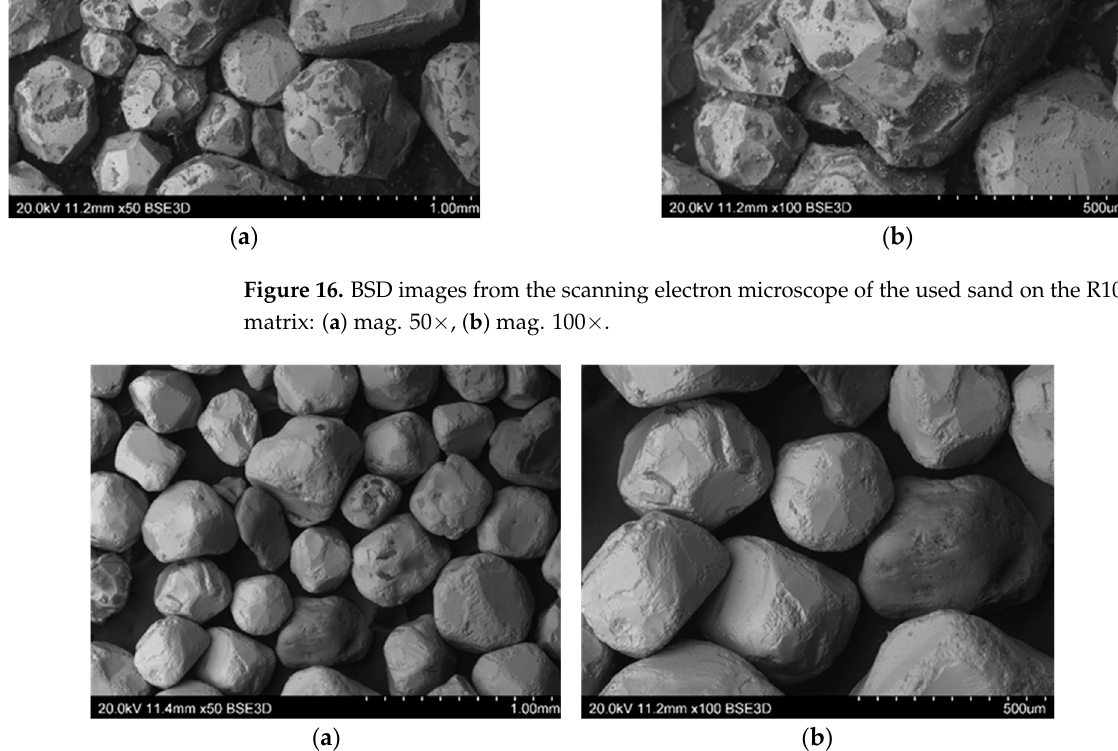
Figure 17. BSD images from the scanning electron microscope of mechanical reclaimed material after 5 min of treatment of the used sand on the RM5M100 chromite matrix: ( a ) mag. 50×, ( b ) mag 100×.